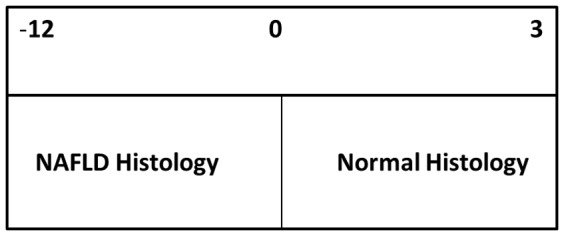
This figure graphically displays the range of the scores for the Healthy Liver Score and the corresponding liver histology.